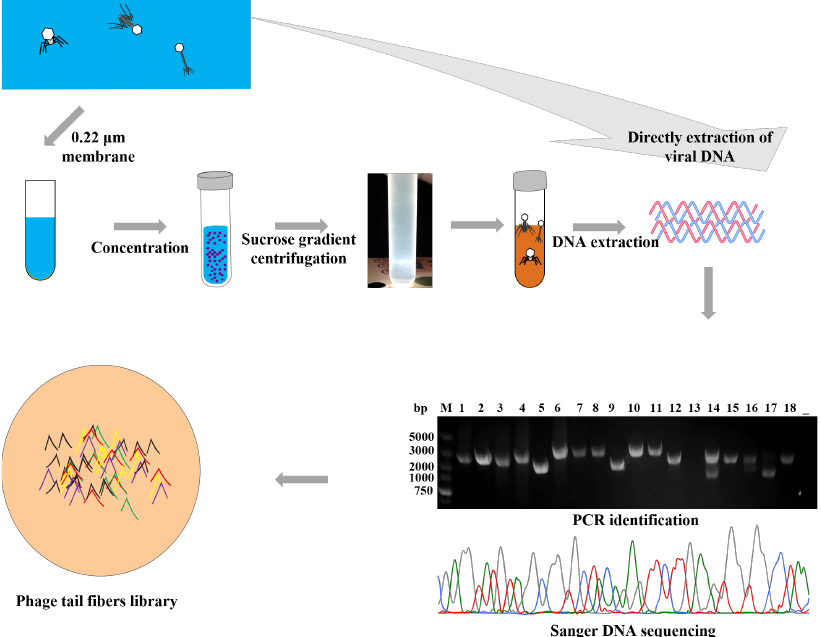
Figure 2. Schematic showing the collecting of phage-tail fiber genes. The phage particles were puri- fied by CsCl gradient ultracentrifugation. Amplified PCR product from phage-tail fiber genes, and the numbers 1-18 represent the different phage-tail fiber gene fragments.